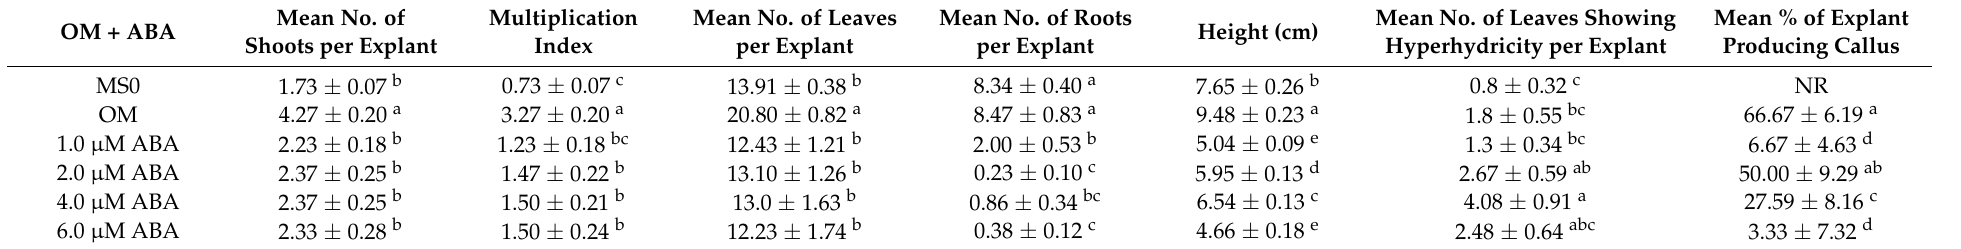
Table 5. Effects of ABA on mean number of shoots, multiplication index, leaves and roots per explant, mean percentage (%) of explant producing callus, height and mean number of leaves showing vitrification (hyperhydricity) per